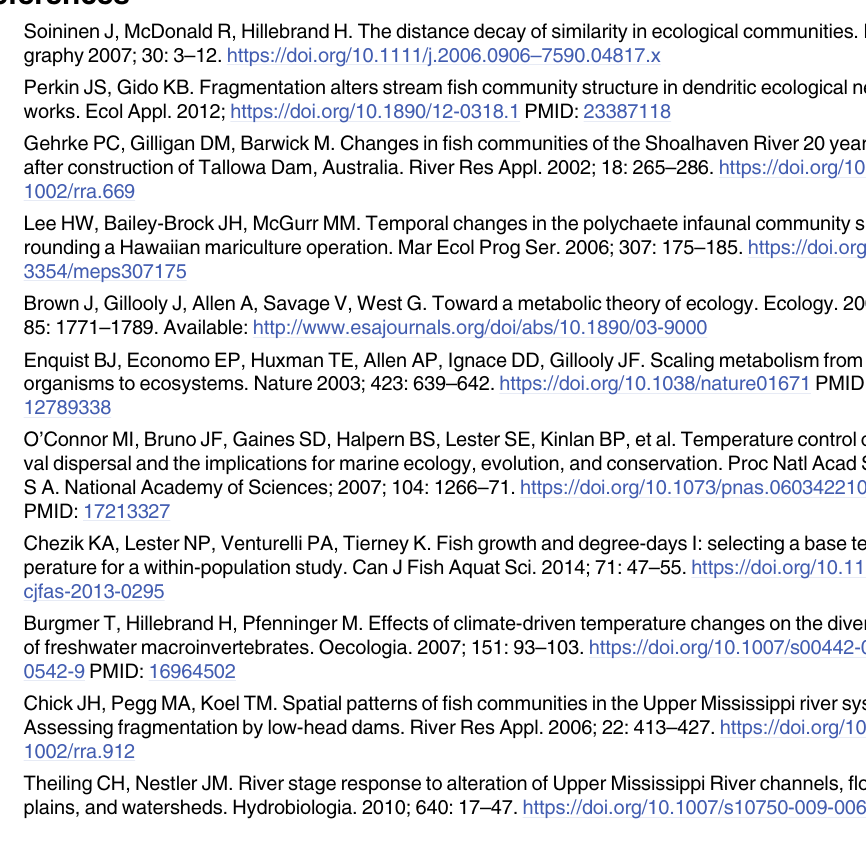
S1 Table. Species observed in the long term resource monitoring program’s daytime elec- trofishing data. � denotes species that made up more than 1% of the catch in at least 1